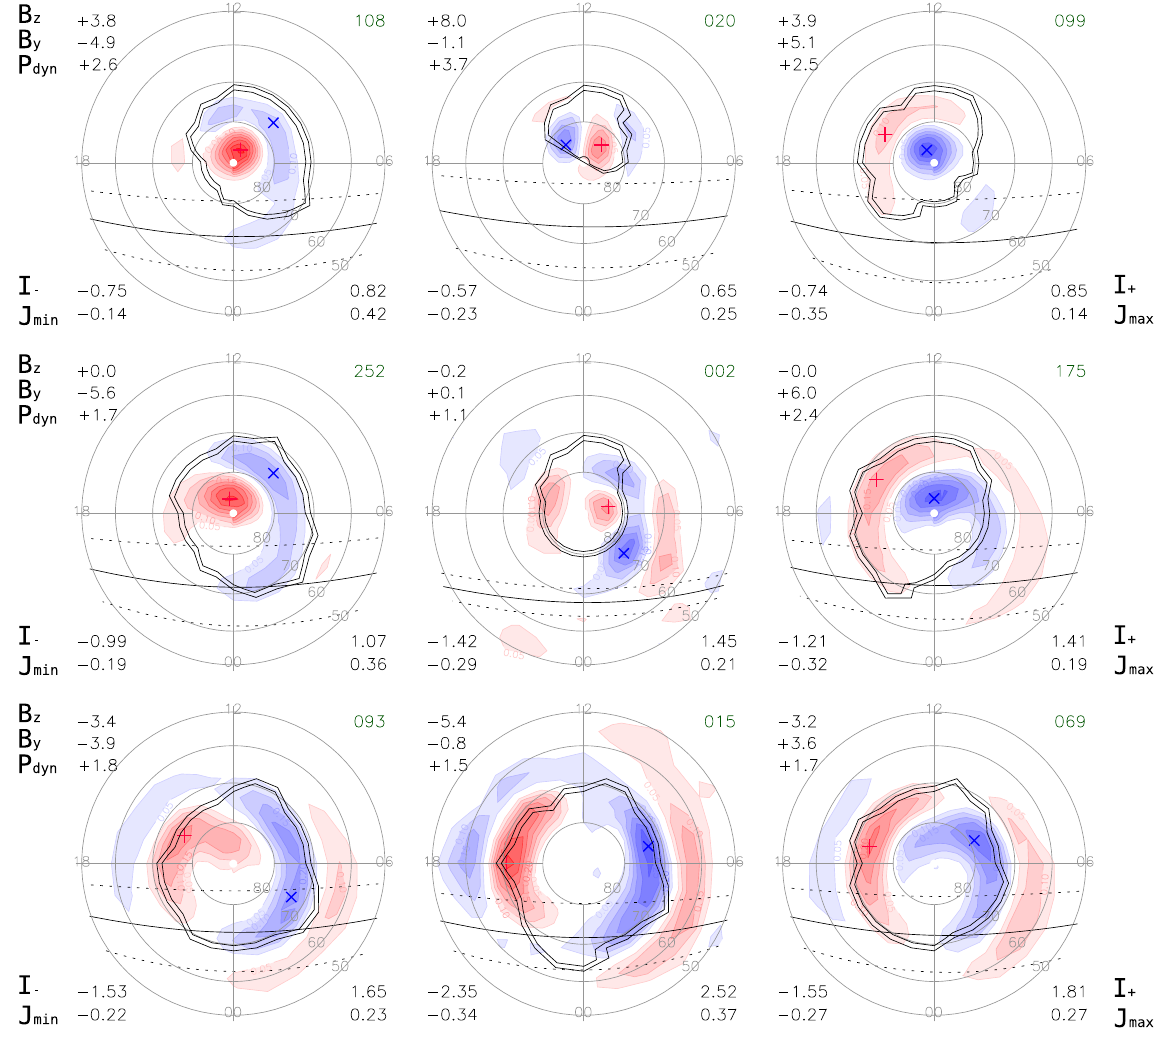
Fig. 7. Southern Hemisphere summer average field-aligned current distributions viewed as seen from above the Northern Hemisphere through the Earth. For full figure description see Fig.